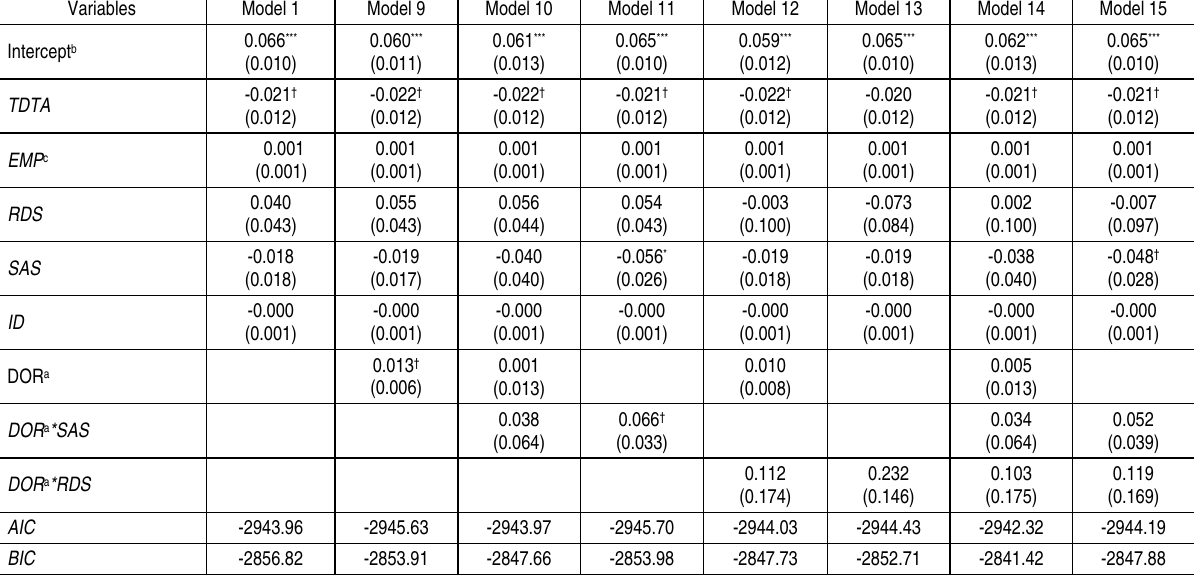
Table 5. Results of additional multilevel analysis a for testing Hypotheses 1 and 2a,